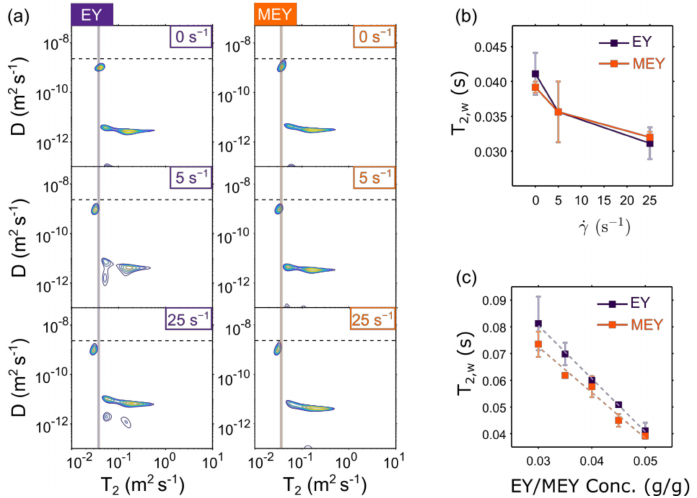
Figure 4. ( a ) 1 H D-T 2 NMR correlation maps of EY (left) and MEY (right) emulsion formulations before shearing (top) or after shearing at 5 s − 1 and 25 s − 1 for 300 min. The horizontal dotted line in all plots corresponds to the diffusion coefficient of free water at 25 ◦ C. The vertical solid lines in the left and right plots (respectively, in dark purple and orange) correspond to the initial T 2,w value before measurements at constant shear. The T 2, w values of EY and MEY emulsions as a function . γ and ( c ) the concentration of EY/MEY samples at varying of ( b ) the applied constant shear rate dilutions in water. Symbols in plots ( b , c ) are means over two replicates, and error bars are their respective standard